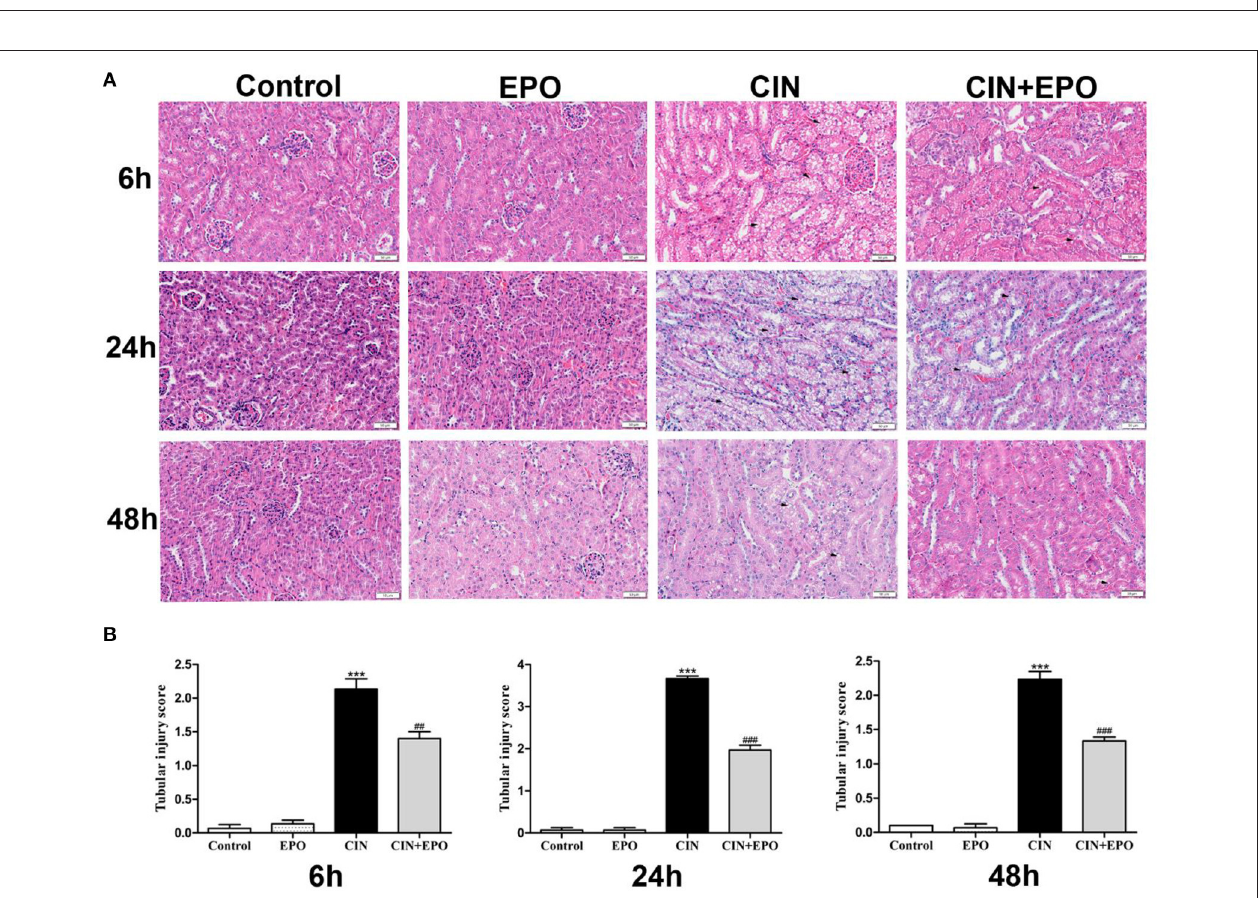
FIGURE 2 | Effect of EPO administration in tubular injury score in CIN. (A) In the four groups, representative images of kidney tissues were stained with H&E at various time points (magnification × 200). (B) The average renal tubular injury scores in the four groups at various time points. *** P < 0.001 vs. the control groups. ## P < 0.01, ### P < 0.001 vs. the CIN groups. EPO, erythropoietin; CIN, contrast-induced nephrology.